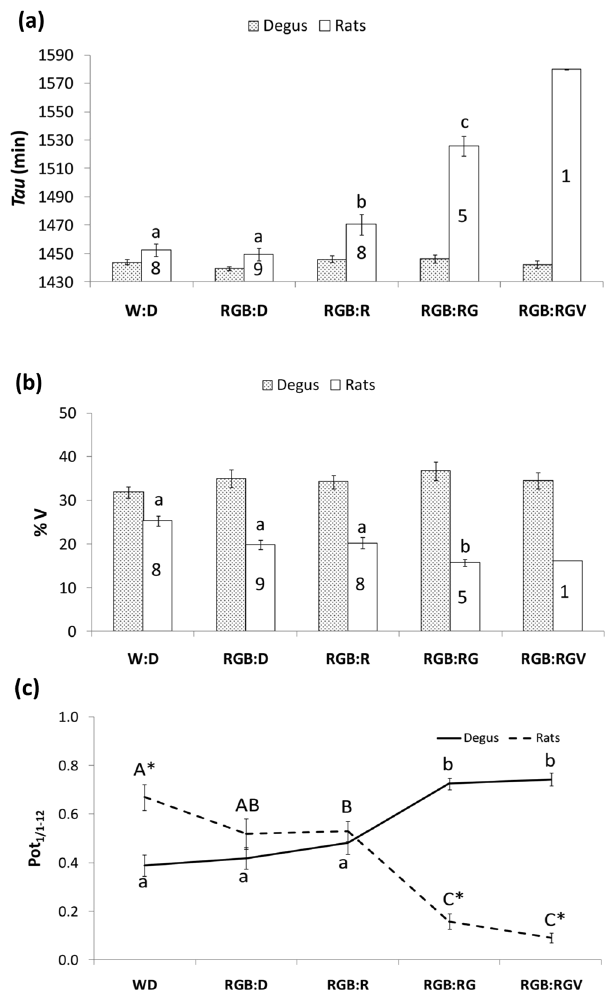
Figure 5. Period, percentage of variance and circadianity index. ( a ) Period ( τ ) and ( b ) %V of wheel running activity rhythm under different lighting cycles for degus (dotted bars) and rats (solid bars) (for more details, see the Materials and Methods section). Only animals showing significant periods were considered for statistical analysis (degus, n = 27; sample size for rats is indicated inside the bars). ( c ) Circadianity Index: Ratio (Pot 1/1-12 ) between the first (Pot 1 ) and the accumulative power of the first twelve harmonics (Pot 12 ) for degus (continuous line) and rats (dashed line) under each lighting condition. Data are expressed as the mean ± SEM. Different letters indicate statistically significant differences between light conditions (repeated measures ANOVA, Bonferroni post-hoc , p < 0.05). * Indicates statistically significant differences between degus and rats (Student’s t-test, p <